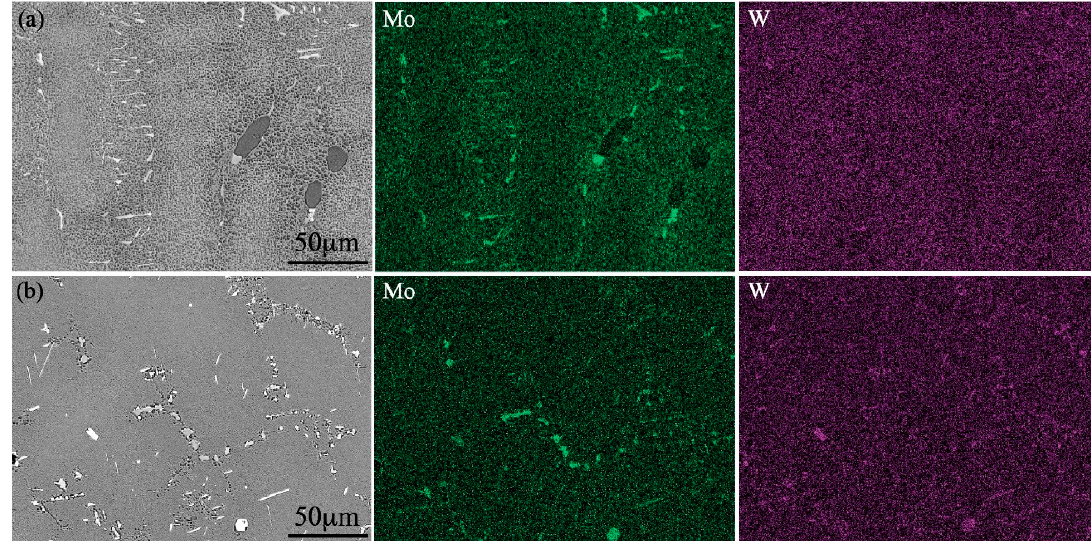
Figure 4. Distribution of Mo and W in Alloy IV: ( a ) cast state, ( b ) heat-treated state. The lattice parameter of the γ and γ′ phases of the high-W superalloys with different Mo contents were determined by XRD. The (004) two-phase reflection was chosen for deconvolution and determination of the lattice parameters of the two phases because of the better signal-to-noise ratio and higher detected data accuracy provided by the high-order peaks [32]. Figure 5 shows the (004) diffraction reflections of the high-W superalloys with different Mo contents. The sharp diffraction peak exhibited in Figure 5a indicates a strong overlap between the individual phases of γ and γ′ , demonstrating a low misfit between the γ and γ′ phases in Alloy I [33]. With the increase in the Mo content, the width of the diffraction peaks increased gradually, which indicated that the misfit between the γ and γ′ phases increased gradually. Furthermore, the diffraction peaks shifted to the left, which demonstrated that the lattice parameter of the γ and γ′ phases increased gradually, as shown in Figure 5b–d. The lattice parameter of the γ and γ′ phases for the high-W superalloys were calculated by the Bragg equation, and the results are shown in Figure 6a. It was found that the lattice parameter of the γ and γ′ phases increased gradually with the increase in the Mo content. In contrast to the γ′ phase, the lattice parameter of the γ phase increased quickly, which indicated that the misfit between the γ and γ′ phases increased gradually. The misfit ( δ ) between the γ and γ′ phases could be calculated by the following equation [34]: